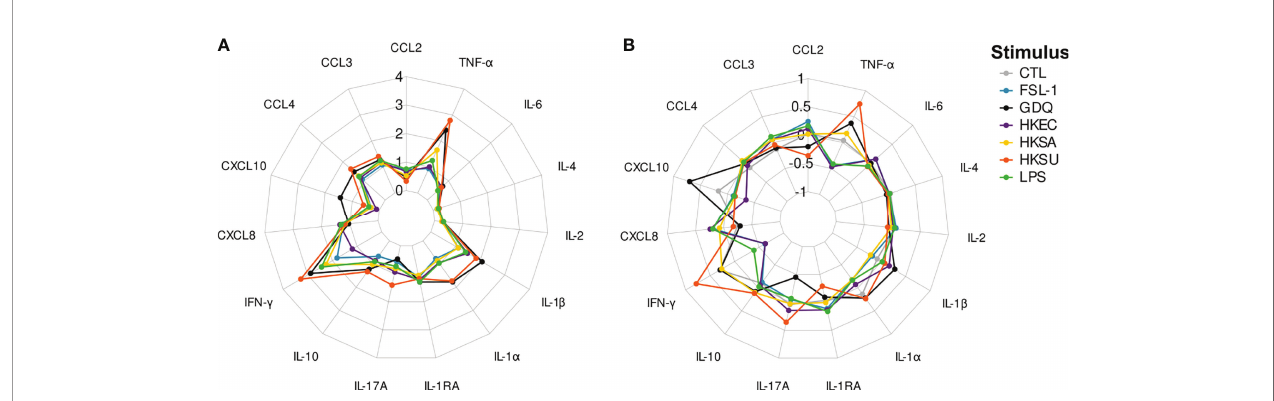
FIGURE 4 | Radarplots of cytokine concentration values obtained for each stimulus. (A) represents the log10-transformed fold-changes induced by a stimulus over the null condition. (B) represents the adjusted concentration values. CTL, FSL-1, GDQ, HKEC, HKSA, HKSU, and LPS stand for control, fi broblast- stimulating lipopeptide 1, gardiquimod, heat-killed Escherichia coli , heat-killed Staphylococcus aureus , heat-killed Streptococcus uberis , and lipopolysaccharide stimuli,